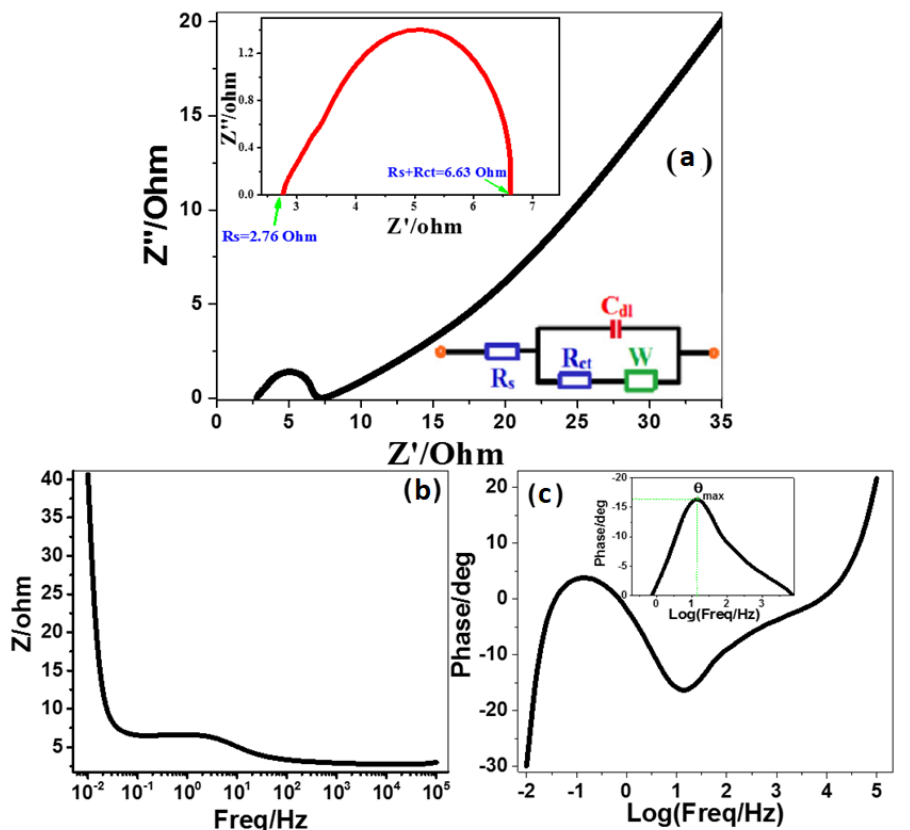
Figure 11. Nyquist plot ( a ) and Bode plots for 3.0% Ni/IrSnO 2 photoelectrode in 0.5 M HCl electrolyte at 25 °C and 0 V (vs. Ag/AgCl) and under visible light illumination; ( b ) the variation of the total impedance with frequency and ( c ) the variation of phase with frequency. The inset circuit of (a) represents a simple Randle equivalent circuit. The inset of ( c ) shows the value of θ max .